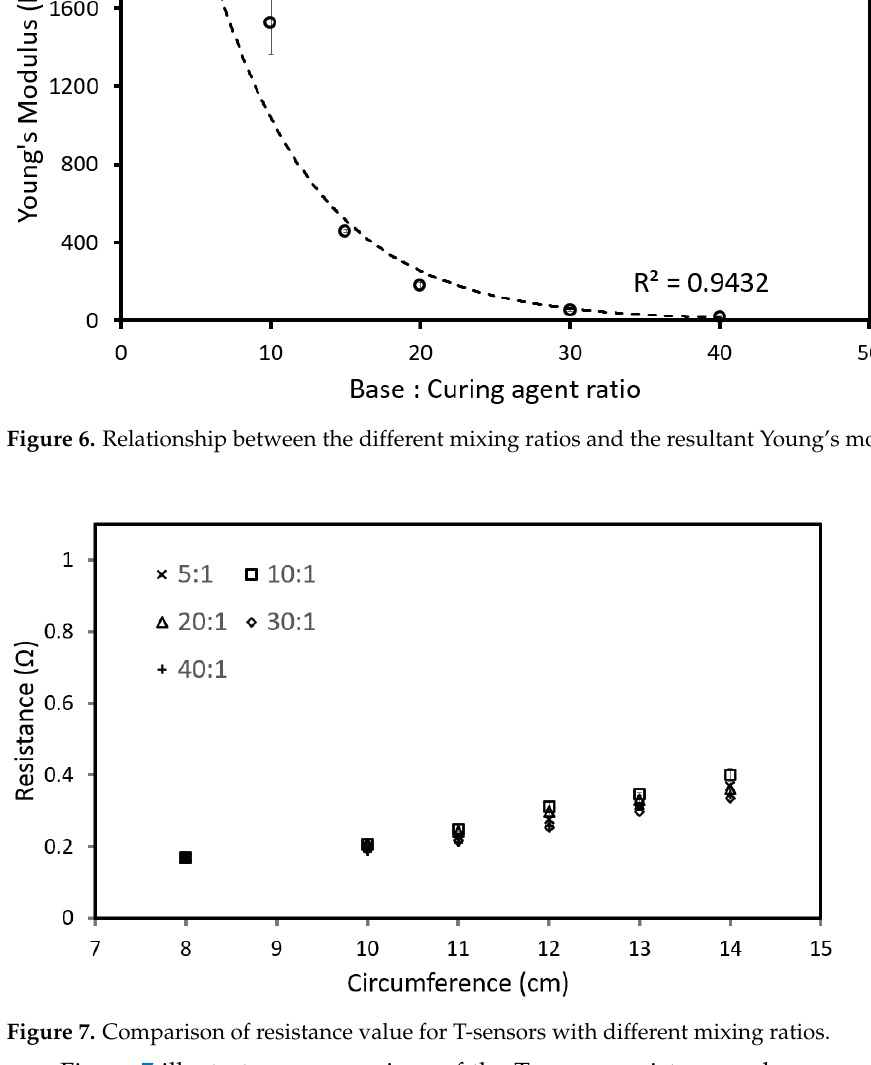
Figure 8. Comparison of resistance value for R-sensors with different mixing ratios.